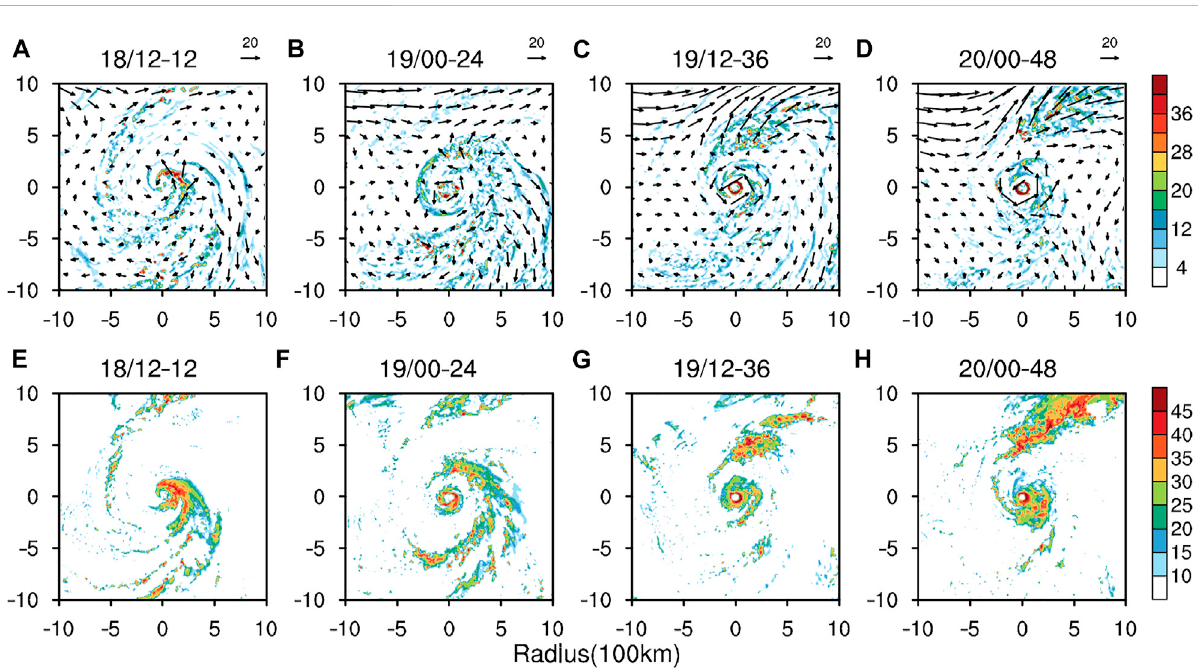
FIGURE 7 (A,B,C,D) Thesimulated200-hPawind fi eld(vectors,m s − 1 )anddivergence(shadedareas,10 – 5 s − 1 )and (E,F,G,H) theradarre fl ectivity(dBZ)at1- km height (around 850 hPa) at (A,E) 1200 UTC 18 September (12-h integration) (B,F) 0000 UTC 19 September (24-h integration) (C,G) 1200 UTC 19 September (36-h integration) and (D,H) 0000 UTC 20 September (48-h